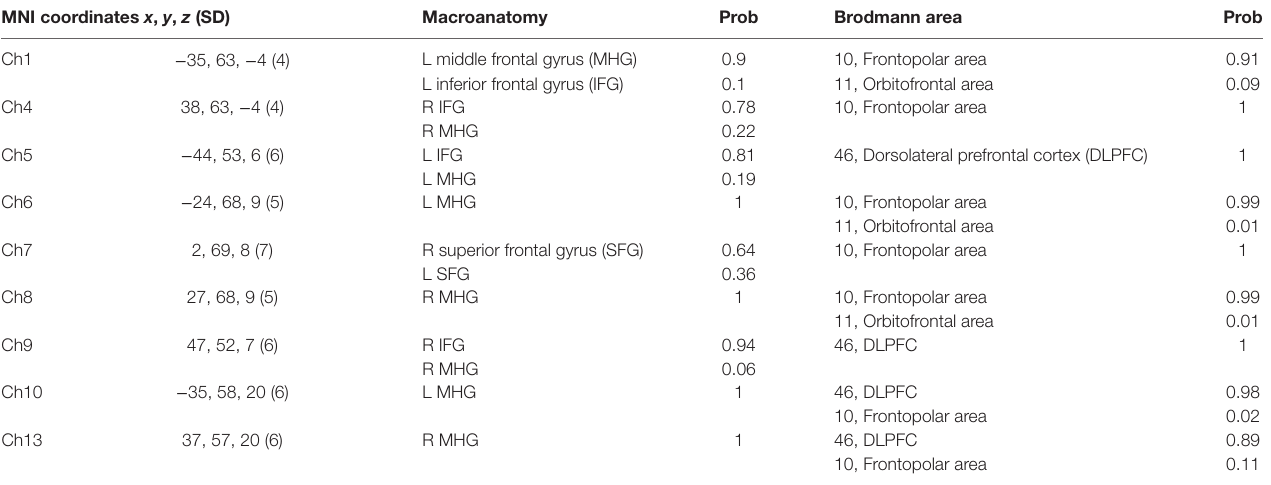
Table 1 | Spatial profiles of the channels among region-of-interest